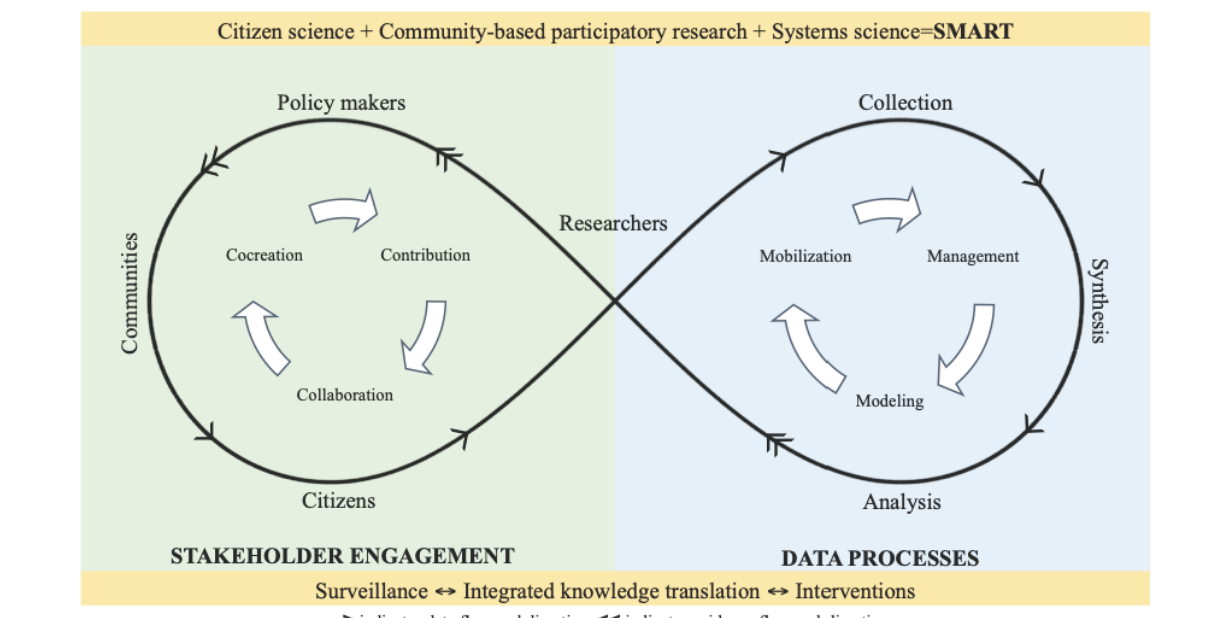
Figure 1. The Smart